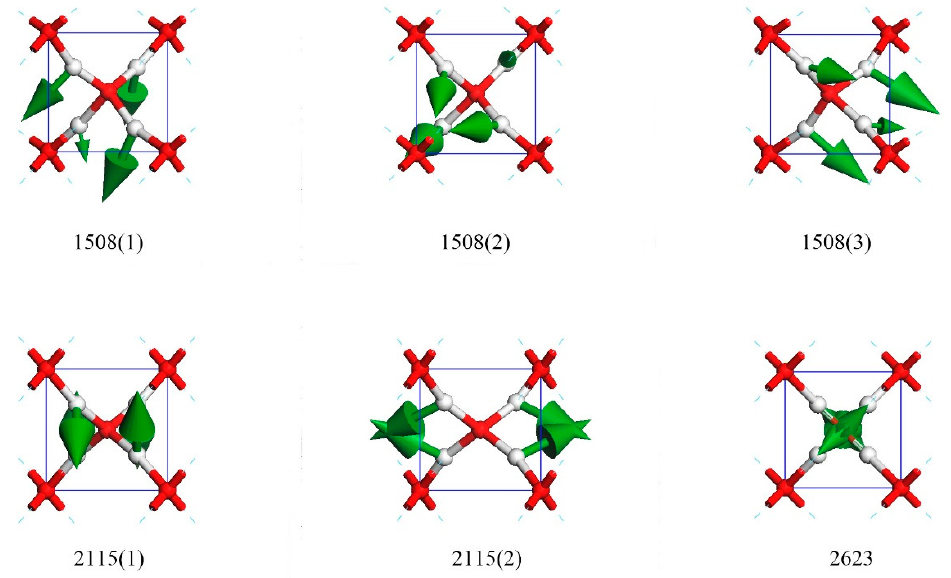
Figure 4. Six normal vibrational modes at 1508 cm − 1 , 2115 cm − 1 , and 2623 cm − 1 . The maximum strength at 2623 cm − 1 was non-degenerate.